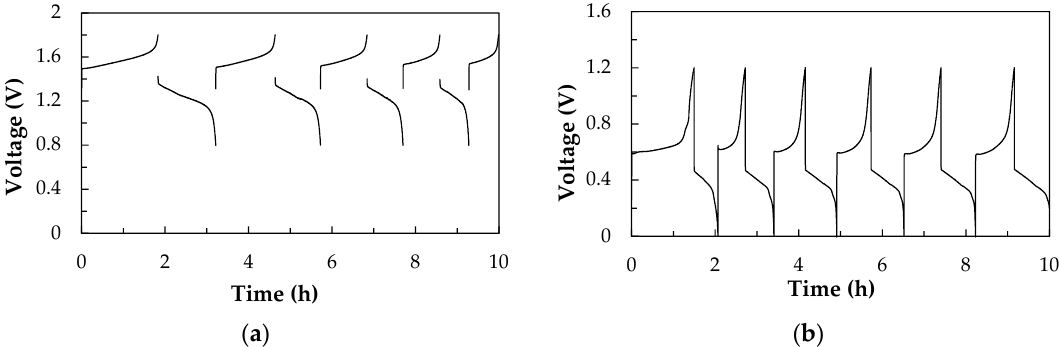
Figure 2. Charge-discharge diagrams of ( a ) all-V RFB, a 1.0 M VOSO 4 / 2.0 M H 2 SO 4 mixing solution was using as negative and positive electrolytes. ( b ) V / I RFB, a 1.0 M VOSO 4 / 2.0 M H 2 SO 4 mixing solution was as the positive electrolyte, iodine / ascorbic acid (1.0 M I 2 / 1 wt% of ascorbic acid / 2.0 M H 2 SO 4 solutions as the negative electrolyte. Both all-V RFB and V / I RFB without modified key components, that is, by carbon paper as the electrode, N-117 membrane as a separator with a serpentine-type flow field at a current density of 40 mA / cm 2 and a flow rate of 60 mL / min. Table 1. The performances of all-V RFB and V / I RFB without modified key components after 10 h charge-discharge test.